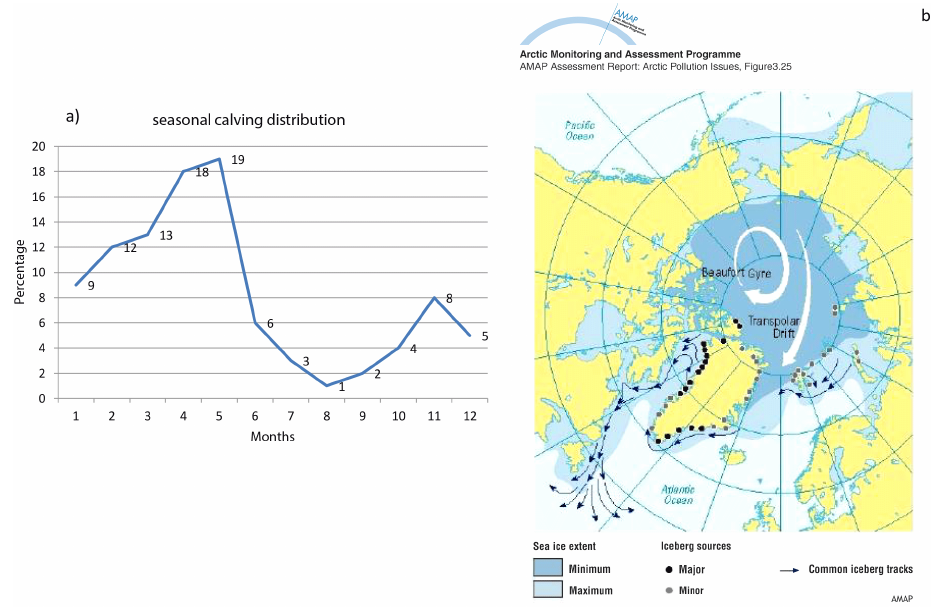
Figure 2. (a) Seasonal calving distribution in percent of yearly mass per month as calculated by Martin and Adcroft (2010); (b) sites and tracks as stated in the AMAP Assessment Report (2007), reproduced with permission.